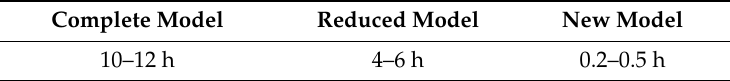
Figure 20. 2D Experiment 3 results vs. literature results [13]. Table 8. The calculation time in three models.